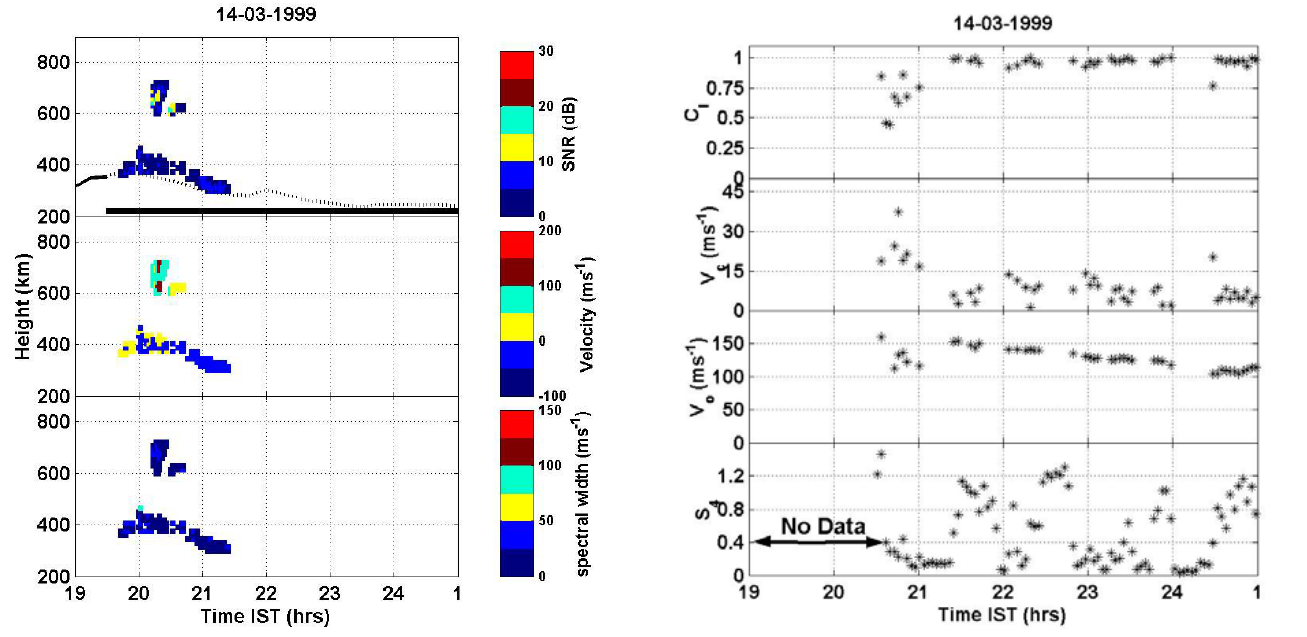
Fig. 4. (a) Same as Fig. 3a but for 14 March 1999 for bottomside ESF structure. (b) Same as Fig. 3b but for 14 March 1999 for bottomside ESF